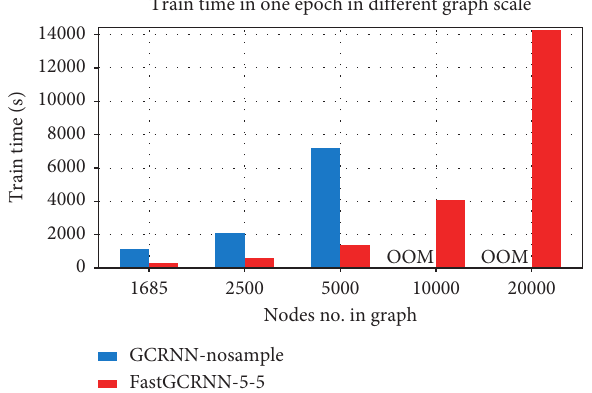
Figure 10: Time consumption of FastGCRNN and GCRNN unsampled models at different graph